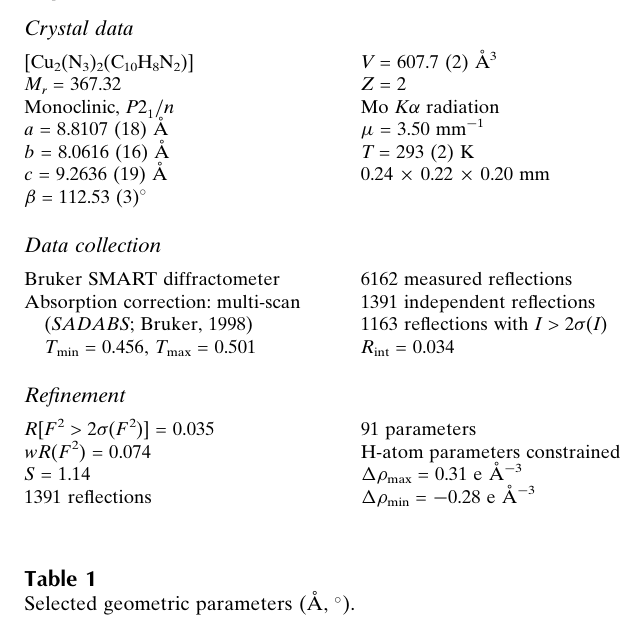
Bruker SMART diffractometer Absorption correction: multi-scan